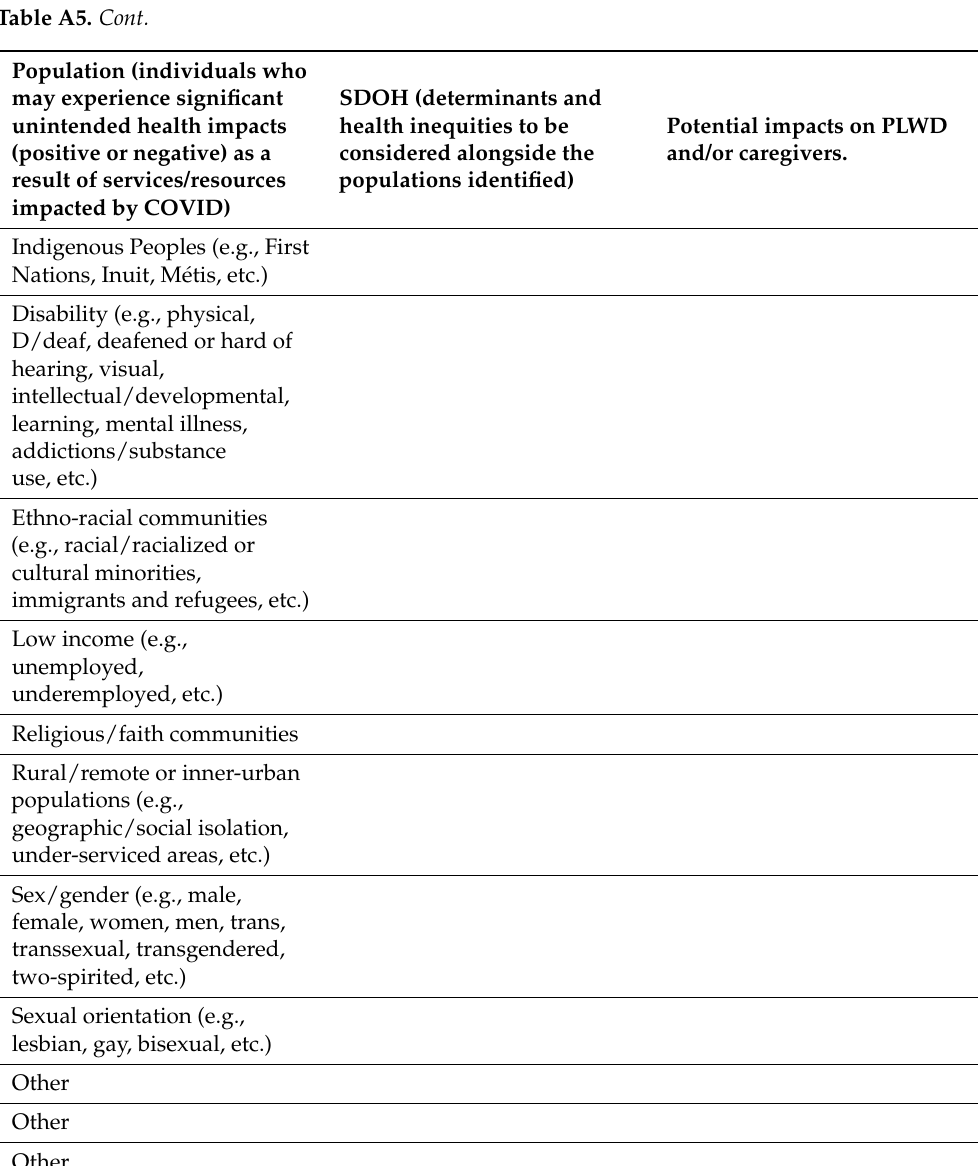
Potential impacts on PLWD and/or caregivers.